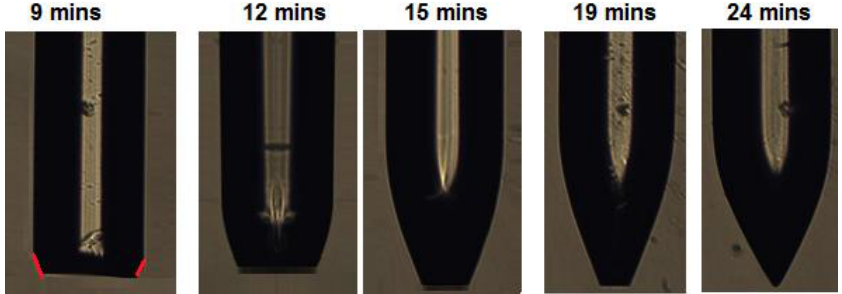
Figure 5. Formation of CPC fiber tip. Five fibers were used. Each fiber was etched with cladding using different etching times. To make the shape visible, the cladding was removed in each case before taking the picture. The picture at 9 min is marked with red tangent lines to indicate the angle 𝛩 C with the dominant PMMA molecular direction along the fiber axis. The vertical bright zones on the fibers are reflections from the microscope light source.